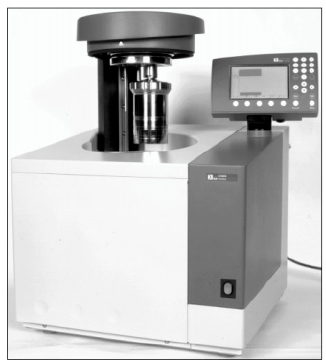
Figure 5. IKA WERKE C 2000 Calorimeter.